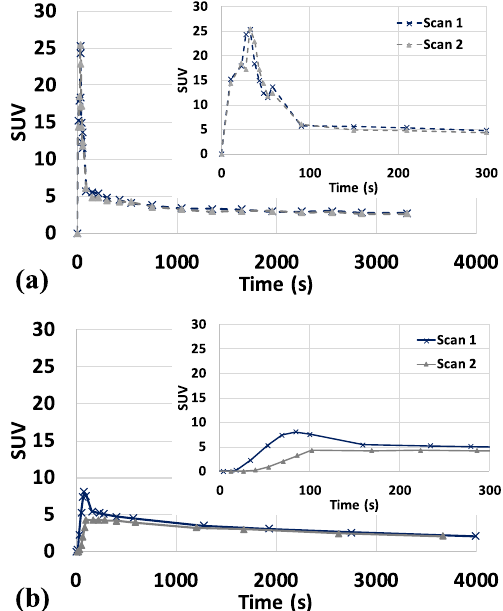
Fig. 8 a IDIFs extracted from two scans of the same subject and b measured venous blood samples for the corresponding scans. Both plots include the whole curve as well as a zoomed‑in focusing on the initial 300 s